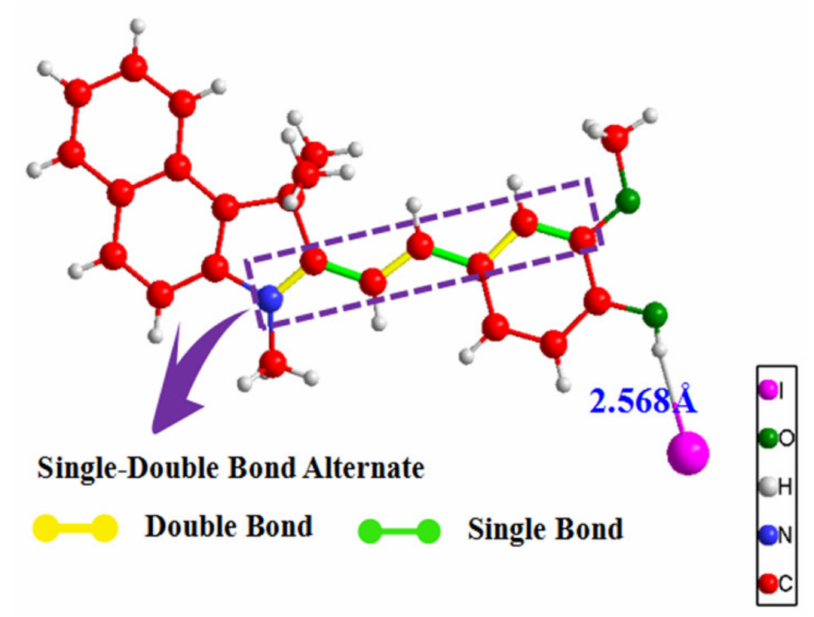
Figure 4. Schematic diagram of 1-TB single molecular structure.